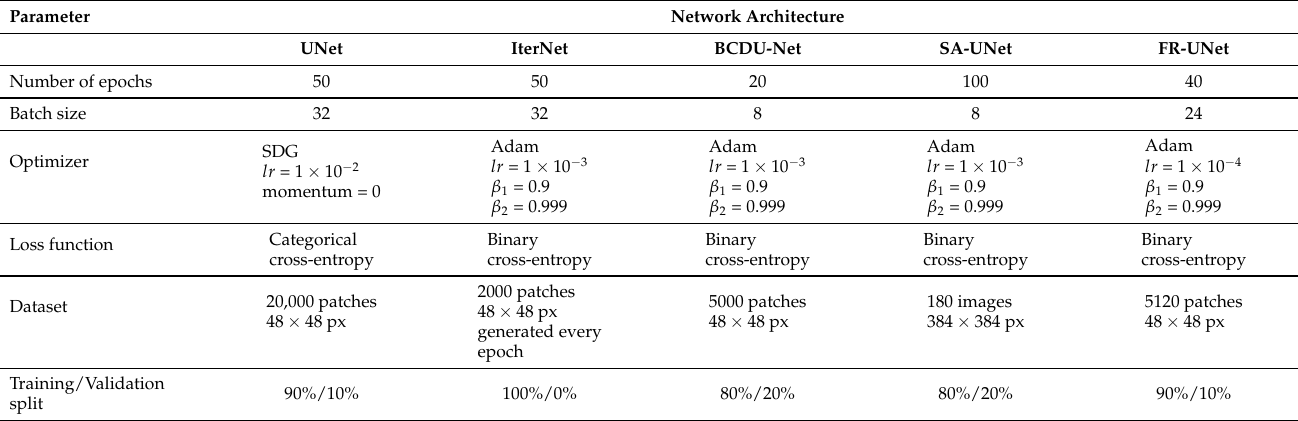
Table 1 lists the setup parameters for the tested network architectures. Table 1. Parameters of the training